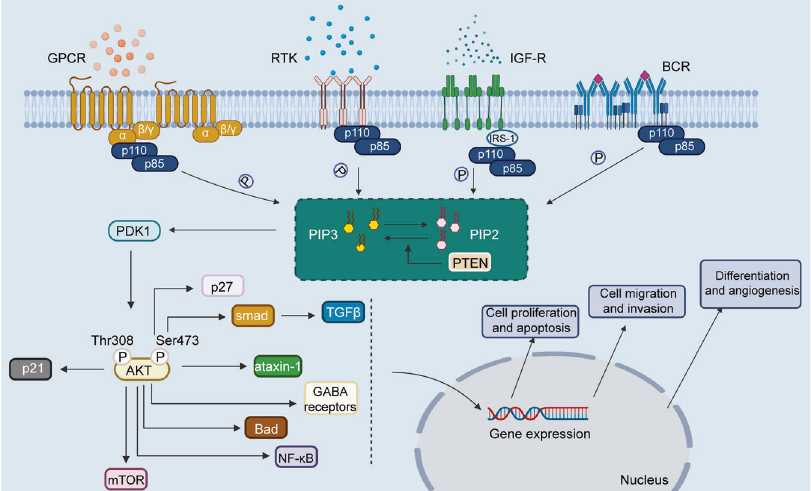
Fig. 2 The activation process of PI3K/AKT signaling pathway. PI3K, composed of one catalytic (p110) domain and one regulatory (p85), can be activated by G-protein coupled receptor, RTK, IGF-R, and B-cell receptor. Activated PI3K facilitates the conversion of PIP2 to PIP3. PIP3 activates PDK1, and then PDK1 phosphorylates AKT at Thr308. AKT can be also phosphorylated, and activated by PDK2 at Ser473. Activated AKT can regulate mangy cellular biological functions by interacting with numerous downstream signaling molecules, such as p21, p27, TGF β , ataxin-1, GABA receptors, Bad, NF- κ B, and mTOR. Image created with BioRender